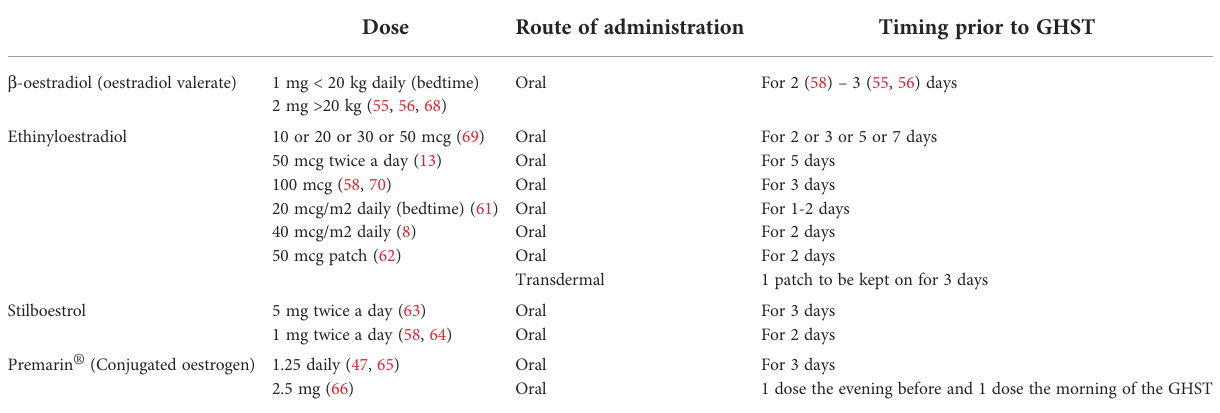
TABLE 2 Sex steroid priming regimens for girls.